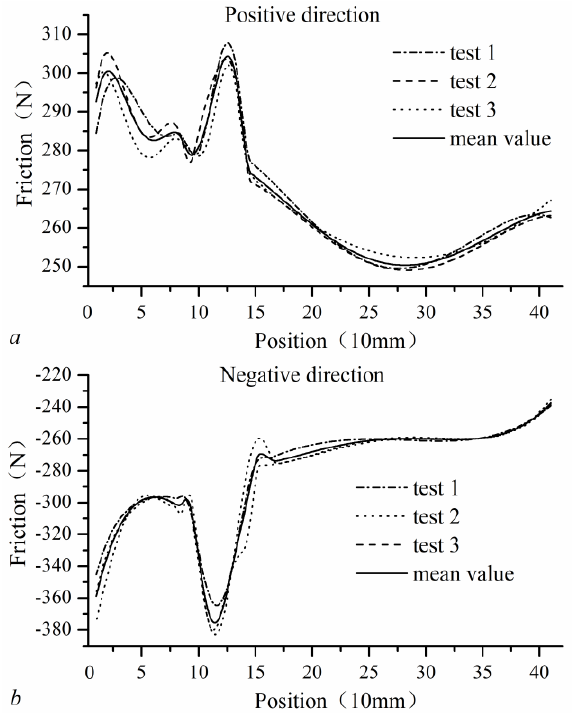
Figure 11. IAFV curves and associated MVOIAF for three tests at a feed velocity of 5 mm/min. ( a ) Position direction; ( b ) Negative direction.